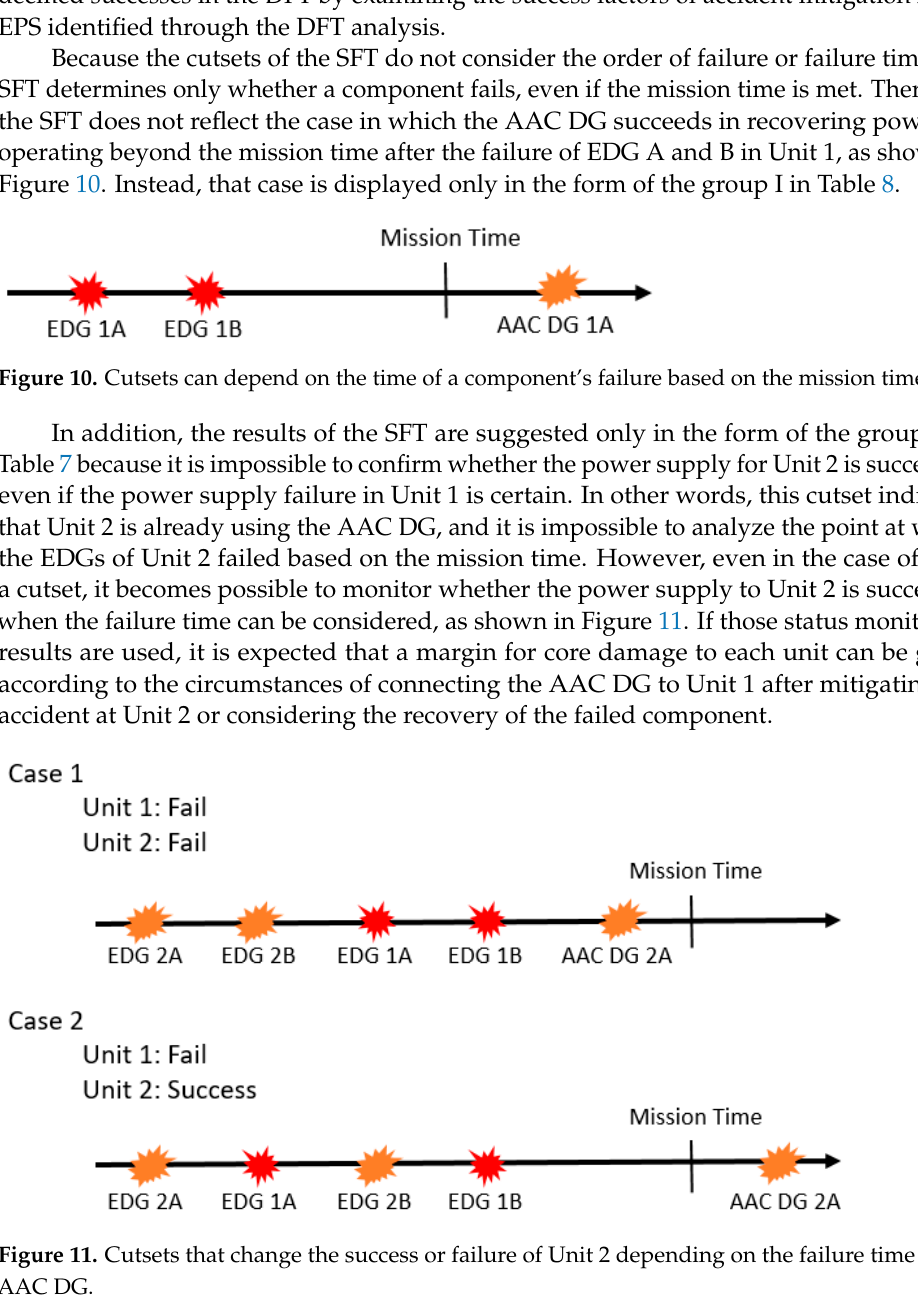
Figure 12. Cutsets for Unit 1 that change to success by considering the order of failures and the status of the power supply for Unit 2.